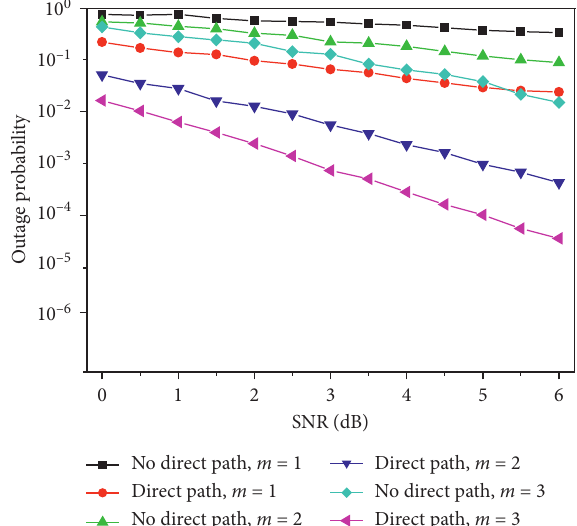
Figure 10: Comparison of outage probability results under the presence/absence of a direct path of the system.